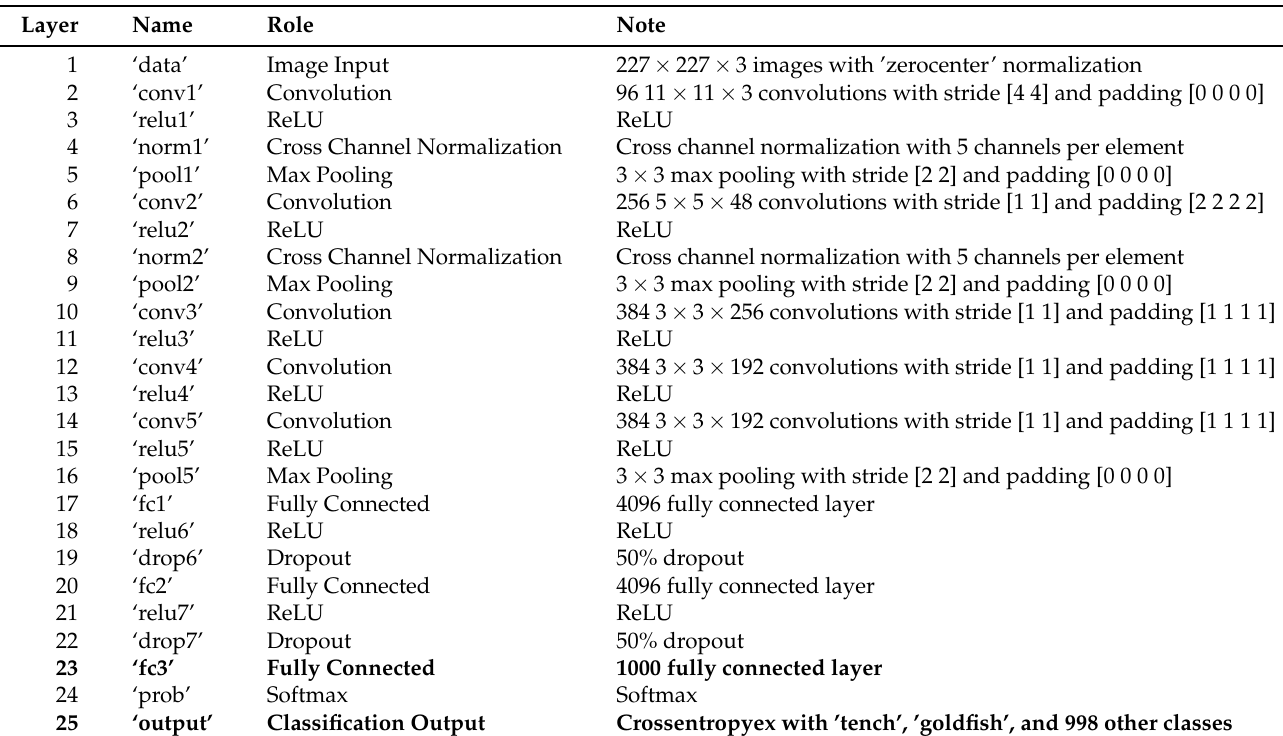
Table 1. Structure of Alexnet implemented on